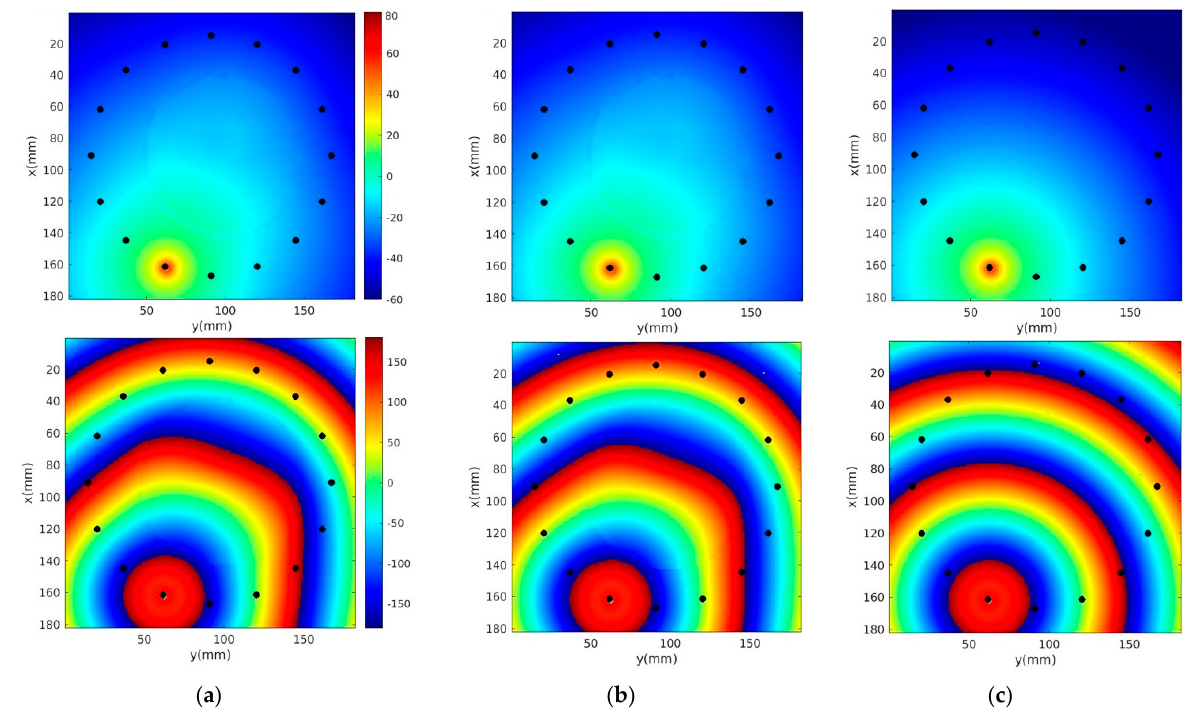
Figure 6. 1300 MHz E z magnitude ( top ) and phase ( bottom ) distributions of a single horizontal plane for the cases ( a ) with and ( b ) without skin, and ( c ) the homogeneous bath. Black dots correspond to antenna locations.